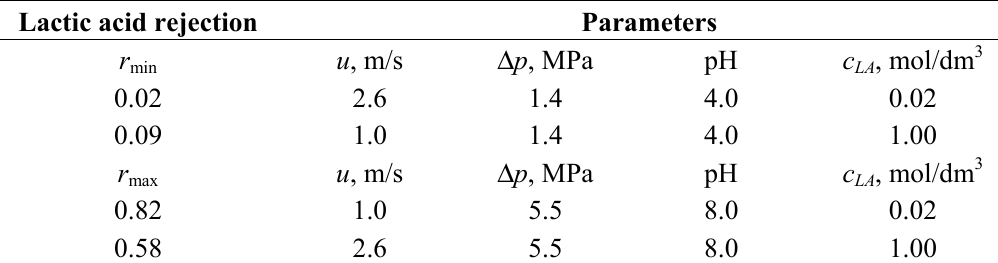
Table 1. Values of operating parameters chosen for flux decline analysis [2,4]. Lactic acid rejection